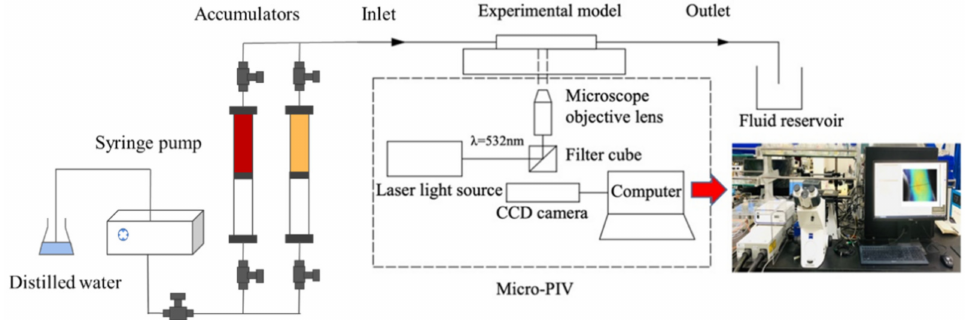
Figure 2. Schematic diagram of the flow system with Micro-PIV